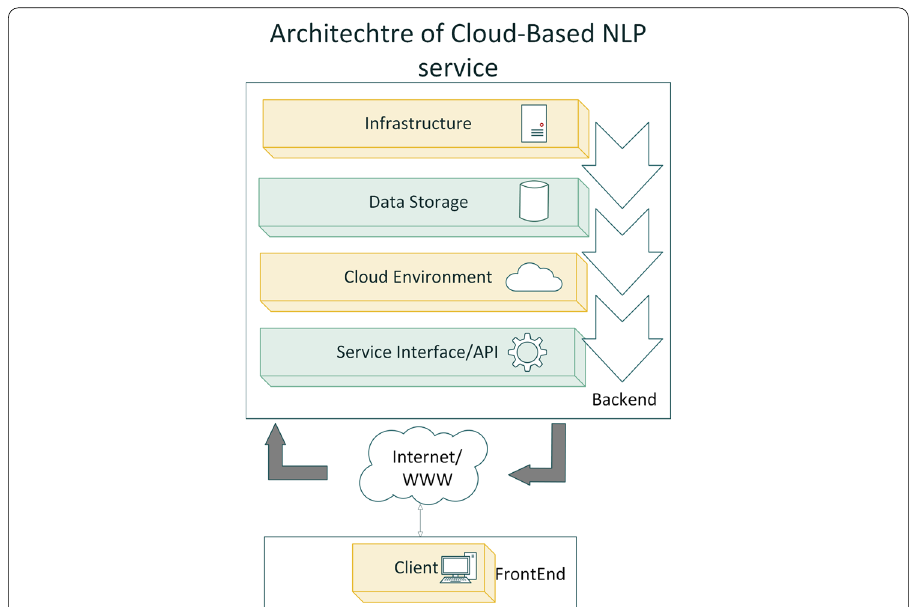
Fig. 2 The architecture of cloud-based NLP platform as a